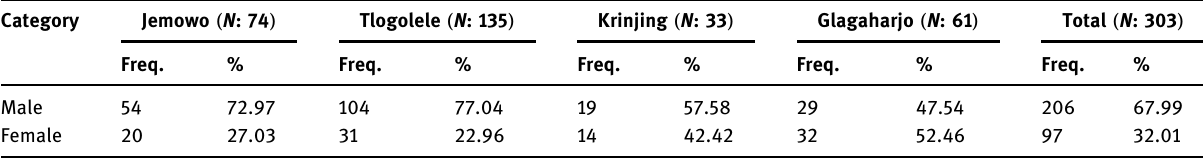
Table 3: Gender of respondents